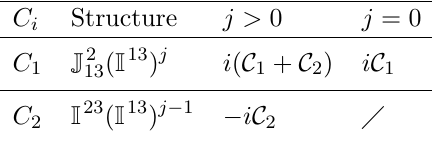
OJO when O has h i